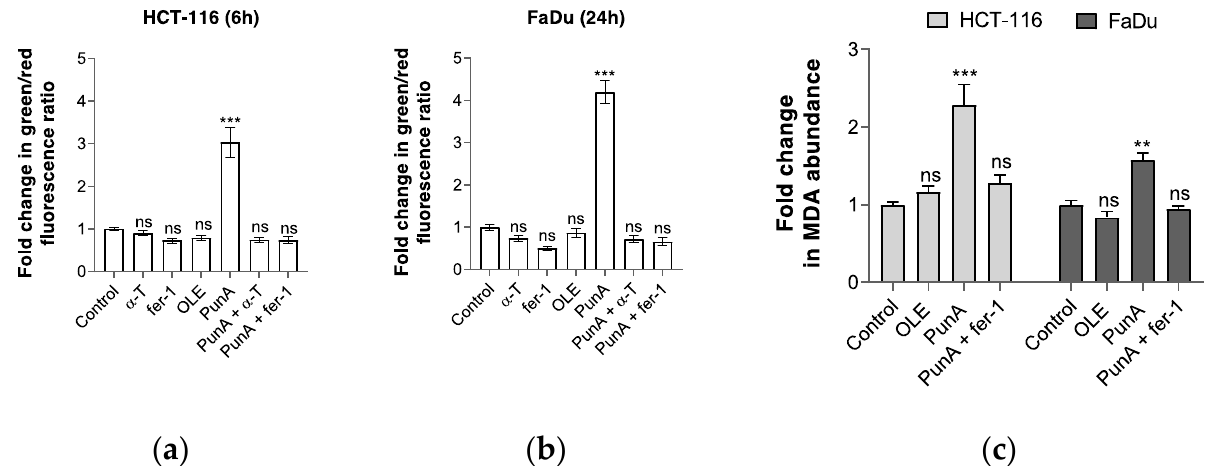
Figure 4. Punicic acid (PunA) treatment largely increases lipid peroxidation in carcinoma cells. ( a , b ) Fold change in the BODIPY green/red fluorescence ratio compared to the control for ( a ) HCT-116 and ( b ) FaDu carcinoma cells treated with α -tocopherol ( α -T) 10 µ M, ferrostatin-1 (fer-1) 10 µ M, oleic acid (OLE) 50 µ M, PunA 14 µ M, PunA 14 µ M + α -T 10 µ M or PunA 14 µ M + fer-1 10 µ M. HCT-116 were treated for 6 h while FaDu cells were treated for 24 h based on kinetic results. ( c ) Fold change in MDA abundance (nmol MDA/mg protein) compared to the control for HCT-116 and FaDu carcinoma cells treated with OLE 50 µ M, PunA 14 µ M or PunA 14 µ M + fer-1 10 µ M. HCT-116 and FaDu carcinoma cells were treated for 18 and 36 h, respectively, based on their viability kinetics. Control: cells supplemented with DMEM cell culture medium without added fatty acid(s). Results are expressed as mean ± standard error of the mean of three independent repetitions. Significance is established in relation to the control. ns, non-significant; ** p ≤ 0.001; *** p ≤ 0.0001.